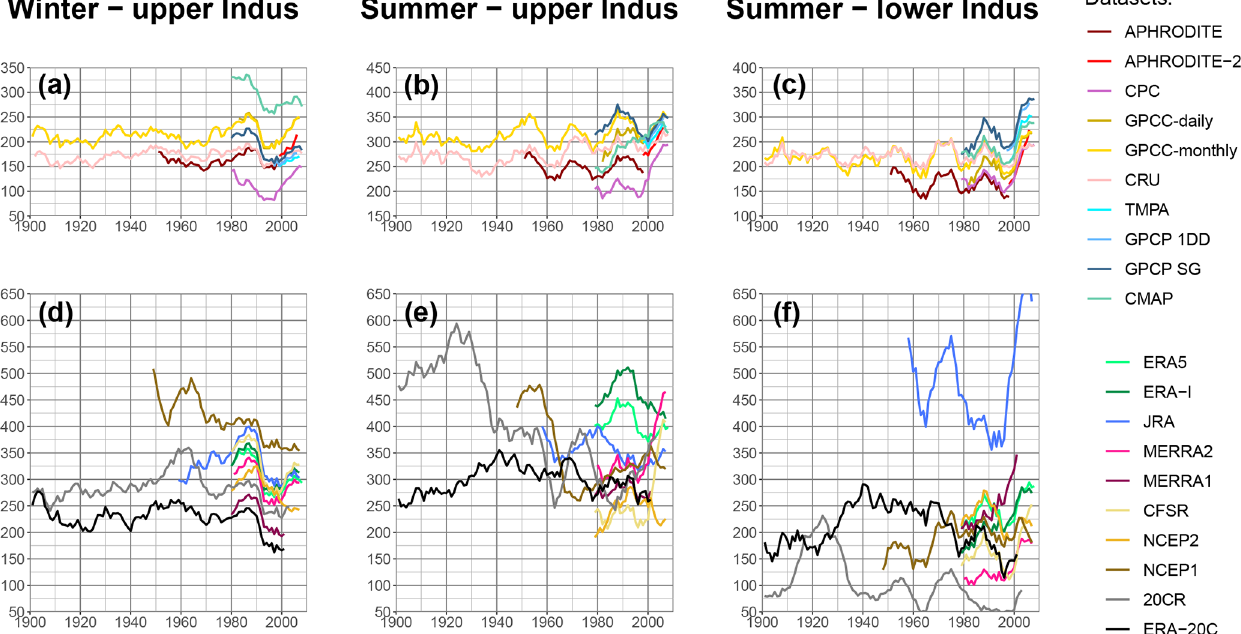
Figure 11. Decadal variability of precipitation using a 10-year running mean for different seasons and domains (winter in the upper Indus: a and d ; summer in the upper Indus: b and e ; summer in the lower Indus: c and f ) and the different datasets (observational datasets: a, b and c ; reanalysis datasets: d, e and f